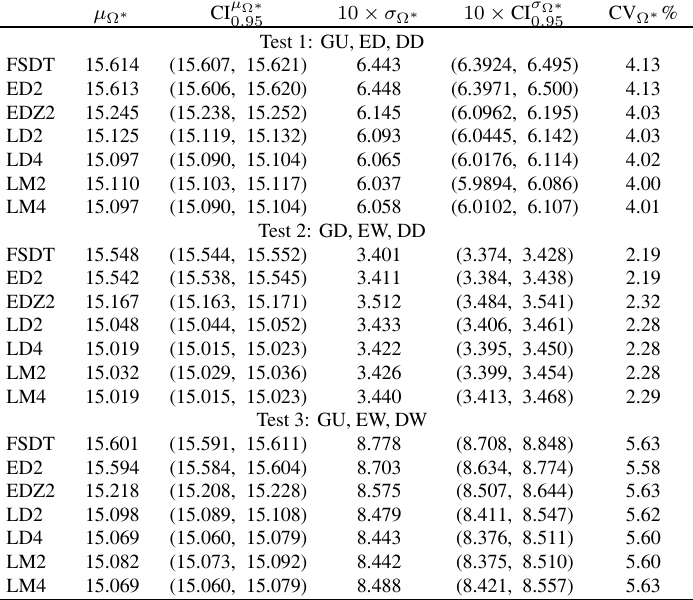
Ω ∗ statistic estimators in the case of the symmetric laminate, fi rst material and